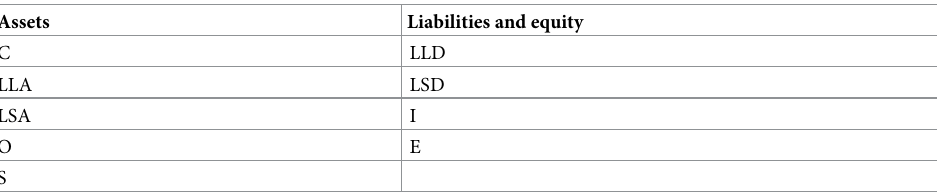
Table 1. Bank balance